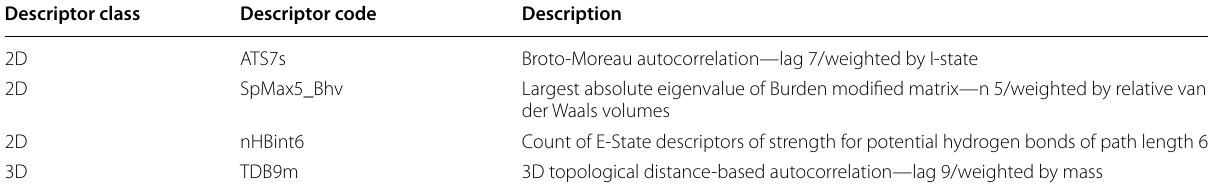
Table 6 Computed model descriptor